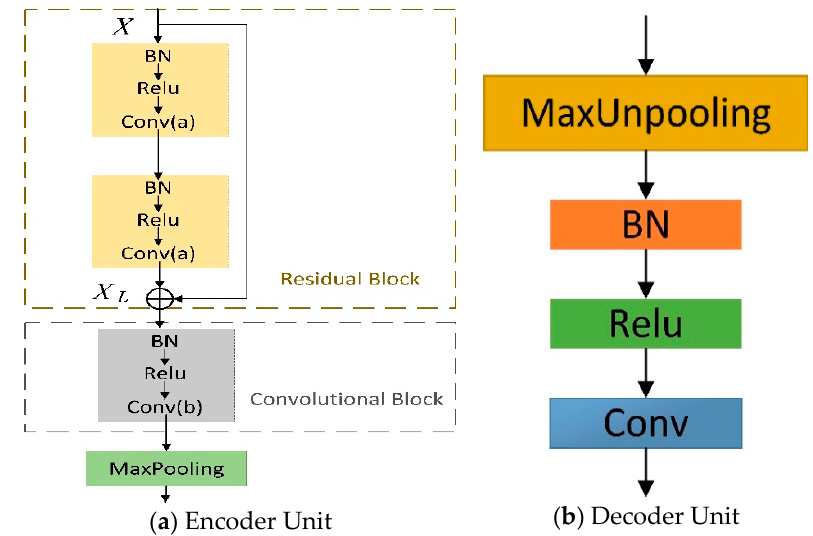
Figure 2. The architecture of an encoder unit ( a ) and a decoder unit ( b ). Table 1. The number of input and output feature